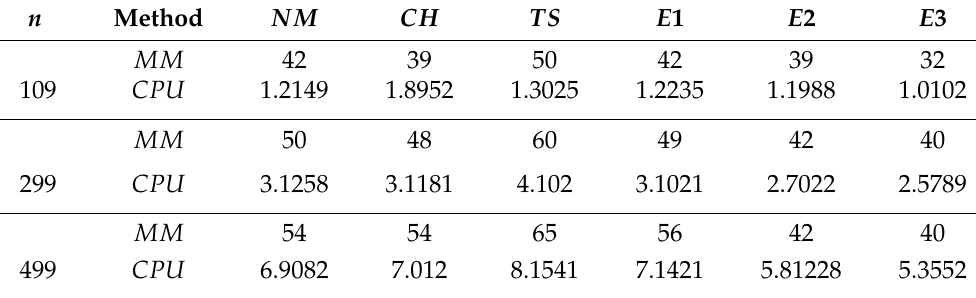
Table 6. Results of Example